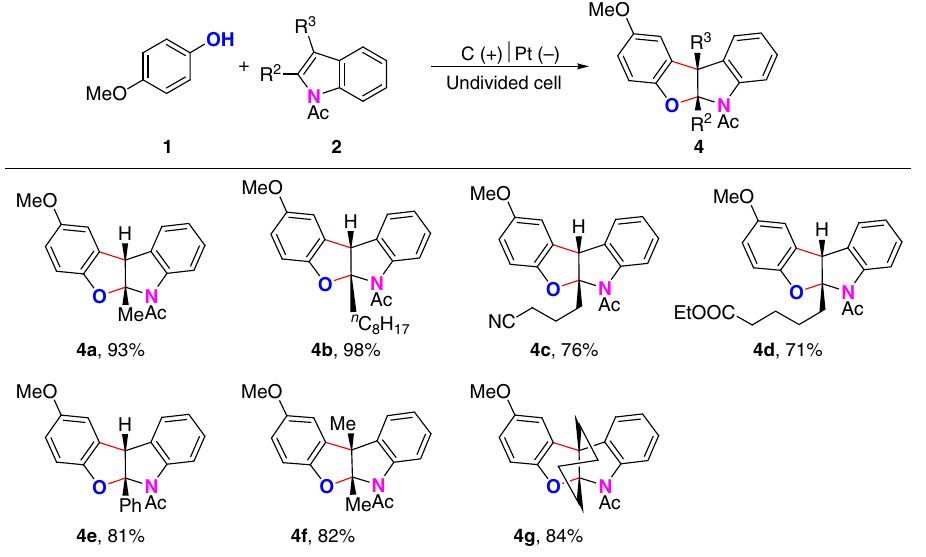
Fig. 3 Synthesis of benzofuro[2,3-b]indolines from 2-substituted N -acetylindoles. Reaction conditions: graphite rod anode ( ϕ 6 mm), platinum plate cathode (15 mm × 15 mm × 0.3 mm), constant current = 10 mA, 1a (0.20 mmol), 2a (0.30 mmol), n Bu 4 NBF 4 (0.20 mmol), HFIP/CH 2 Cl 2 (6.0 ml/4.0 ml), room temperature, N 2 , 1.8 h (3.4 F). Isolated yields are shown